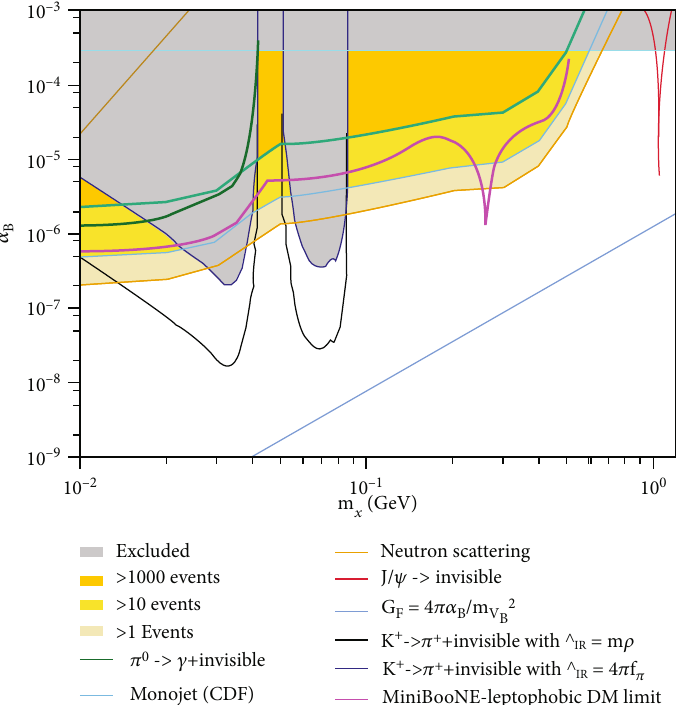
− m χ with B = 3 m χ GeV, ε = 0 , and POT = 1 : 1 × 10 21 . V B